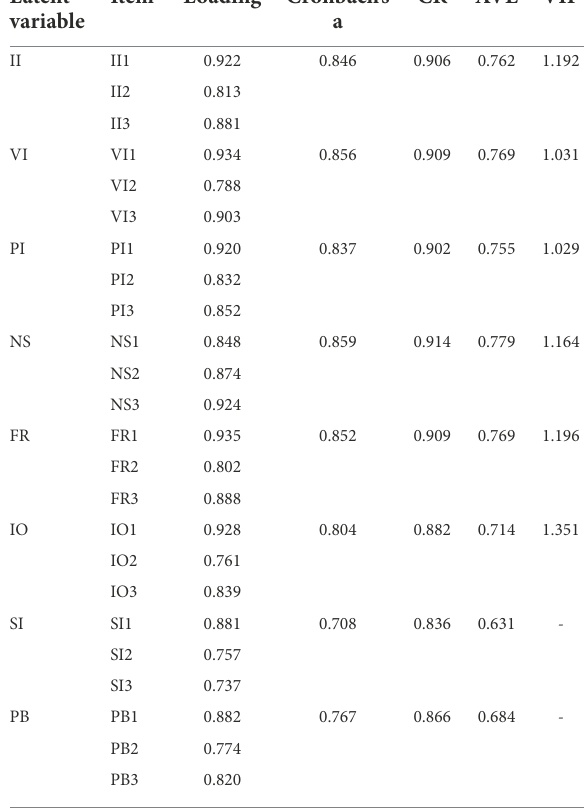
TABLE 2 Results of confirmatory factor analysis (CFA) for the measurement model. Latent variable